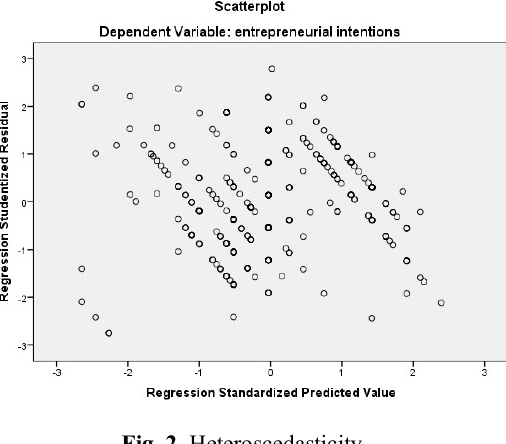
Source: Collected primary data. 2019